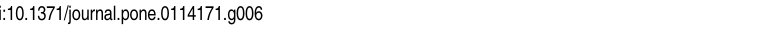
Fig. 6. Hawksbill turtle sighting locations in the central KWNWR,